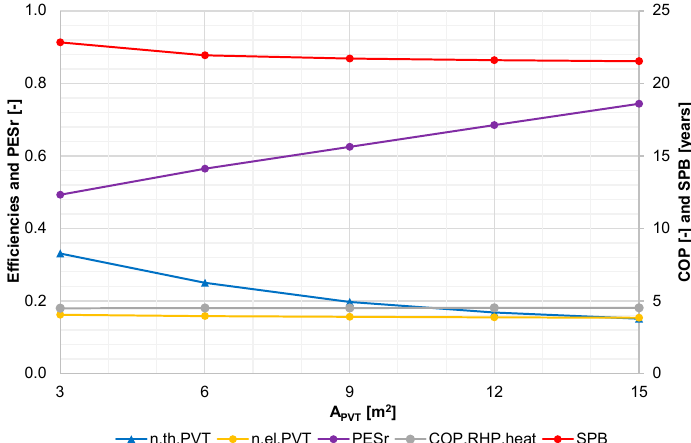
Figure 13. Efficiency, primary energy and economic parameters of the system vs. variation of the PVT area, parametric analysis.